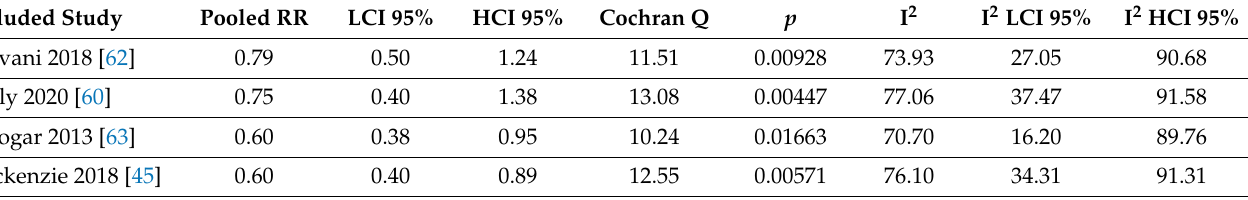
Colorectal Cancer-:Female